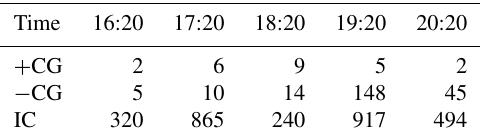
Table 1. Number of + CG, − CG and IC strokes during the MCS activity on 23 July 2009. Data received from the PERUN system. Note: all times are given in